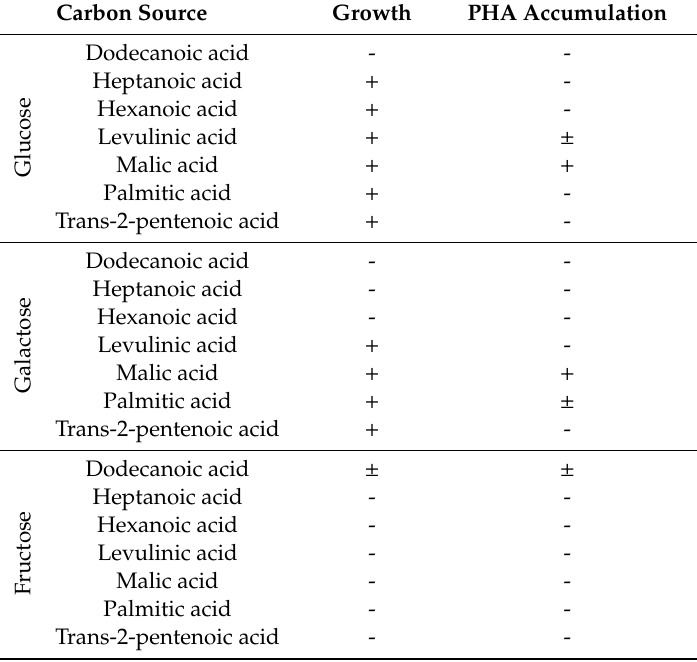
Table 5. Growth and PHA accumulation in Halomonas sp. SF2003 using a di ff erent mixture of carbohydrates and